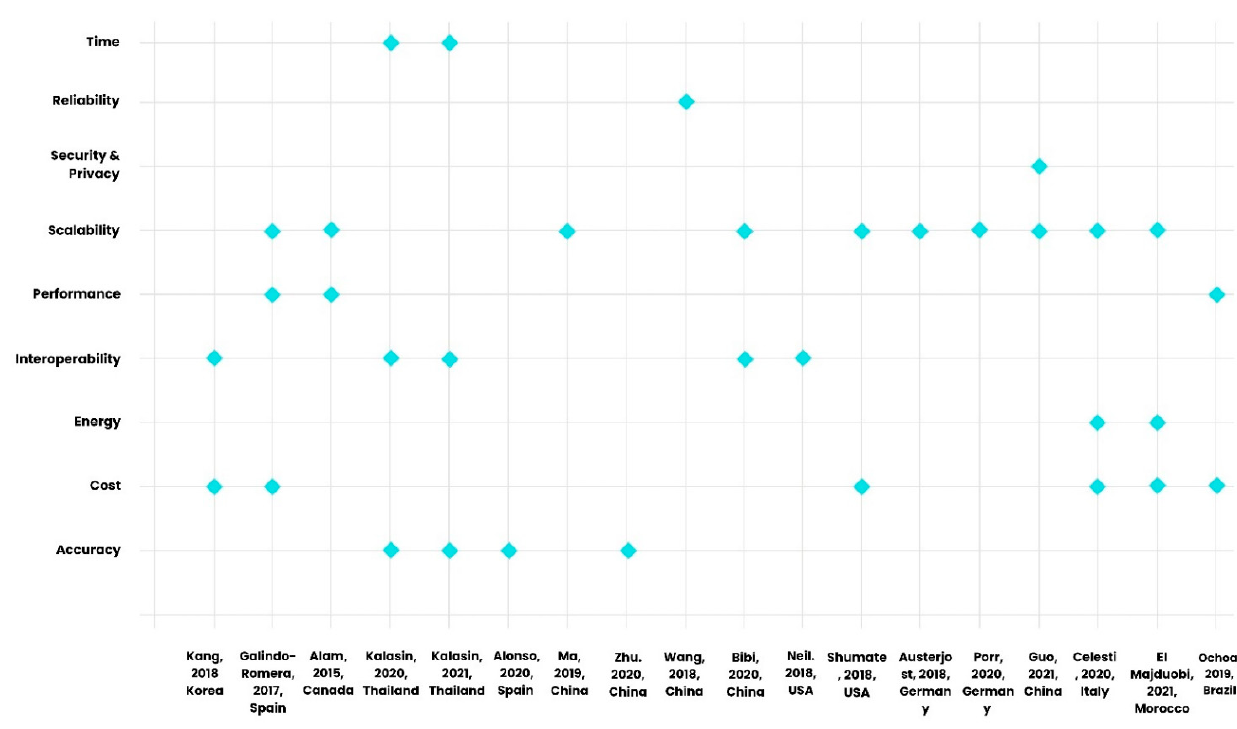
Figure 10. Challenges of IoT technologies from primary studies based on key metrics defined in Section 1.4, depicted in a scatter plot [56–73].